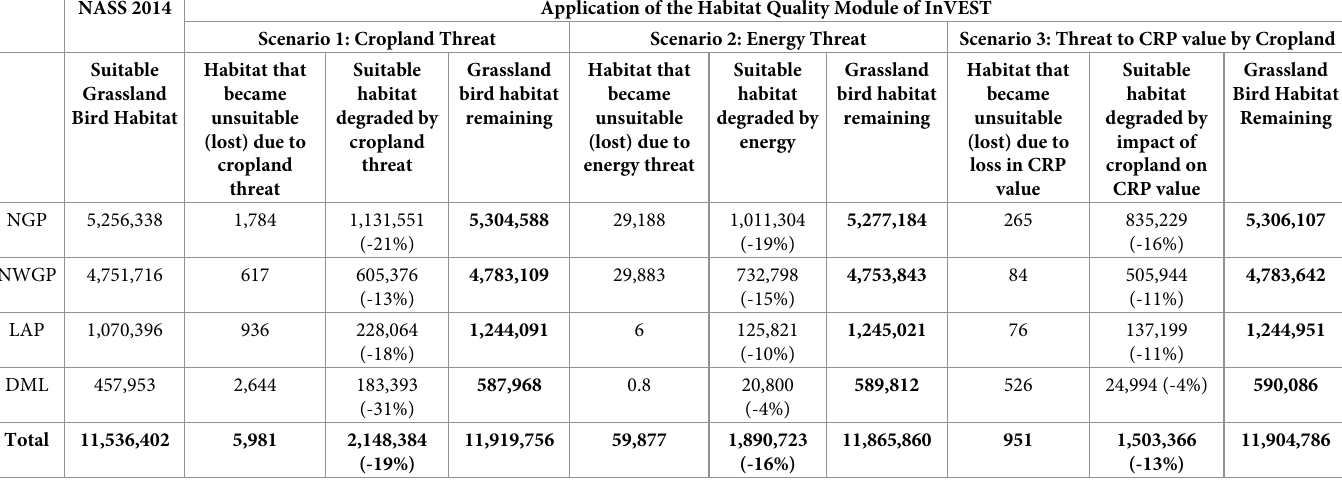
CRP grasslands within the PPR are returned to agricultural production (Table 4; Fig 3A and 3B). Our modeling also reveals that the Des Moines Lobe would have the greatest relative loss of suitable grassland-bird habitat (-36% in our scenario in which all CRP grasslands are con- verted to cropland) and the Northwest Glaciated Plain the least at 3% (Table 4; Fig 3A and 3B). Table 3. Model results of the area (ha) of suitable grassland-bird habitat lost and degraded in four ecoregions of the United States under three threat scenarios: 1) influence of cropland, 2) influence of energy development, and 3) impact on Conservation Reserve Program (CRP) habitat value based on cropland threat. Baseline suitable habitat was quantified using the National Agricultural Statistics Service (NASS) Cropland Data Layer for 2014. Lost habitat indicates suitable habitat that fell below the relative habitat-quality rating of 0.3 on a maximum-scale value of 1.0. Degraded habitat indicates suitable habitat that dropped in habitat-quality ranking but stayed above 0.3 (i.e., was not lost). Values in parentheses represent the percentage of current (2014) suitable habitat degraded under the different scenarios. The ecoregions are the Northern Glaciated Plains (NGP), Northwestern Glaciated Plains (NWGP), Lake Agassiz Plain (LAP), and Des Moines Lobe (DML).